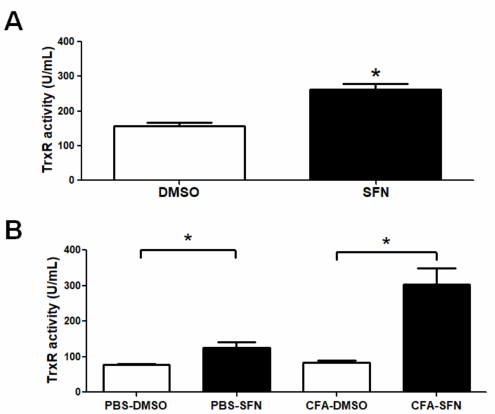
Figure 6. TrxR activity in plasma and synovial fluid samples of mice with mono-arthritis. Plasma ( A ) and synovial fluid ( B ) TrxR activity levels in samples obtained from vehicle- (open bars) and SFN- (closed bars) treated mice. Data are mean ± SEM. Experiments were performed in four different occasions ( n = 14 animals per group). * p <